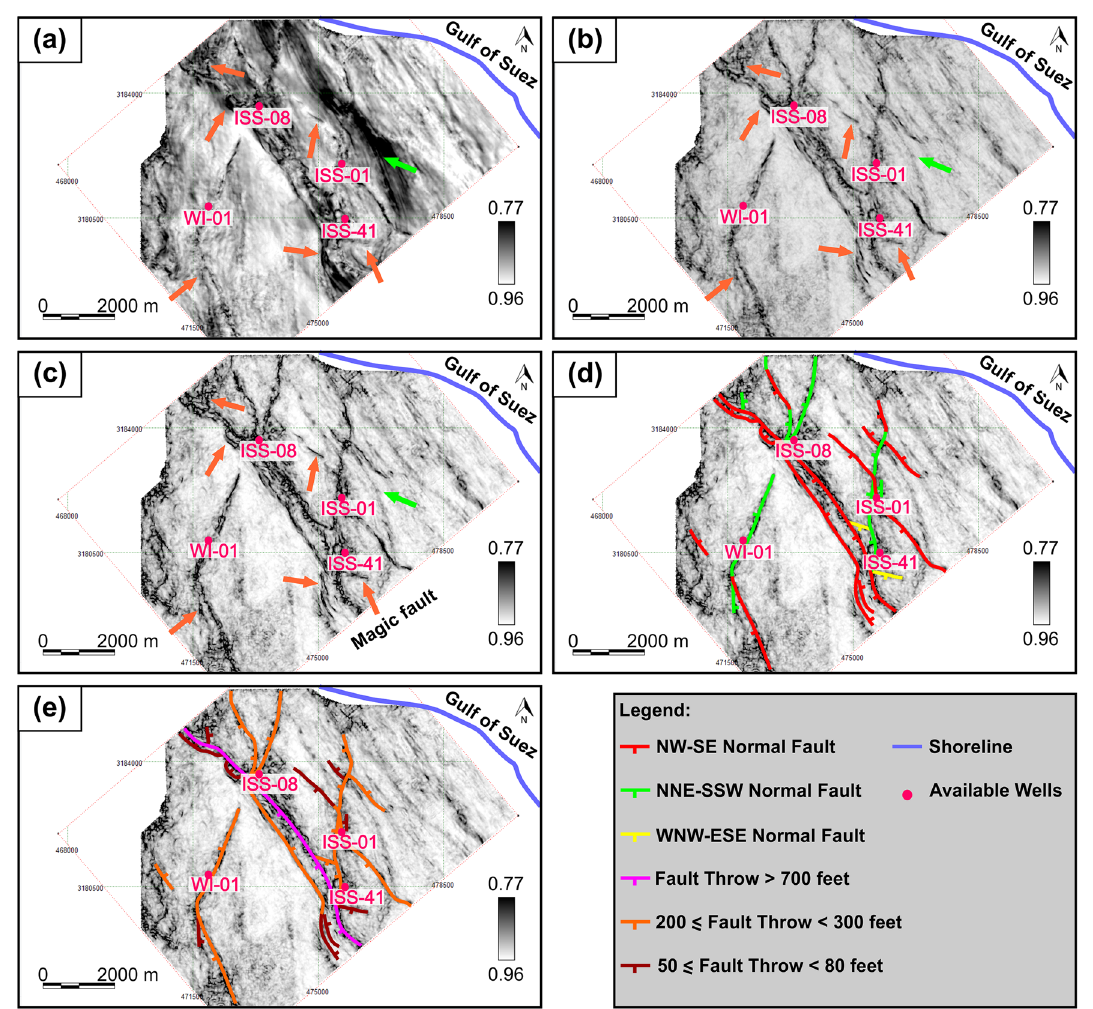
tinuities: a non-steered similarity attribute, b full-steered similarity attribute, c FEF-similarity attribute, d FEF-similarity attribute com- bined with different fault trends, and e FEF-similarity attribute com- bined with different fault trends, color coded with fault throw magni- tude. The green arrow points to the black shadow caused by the